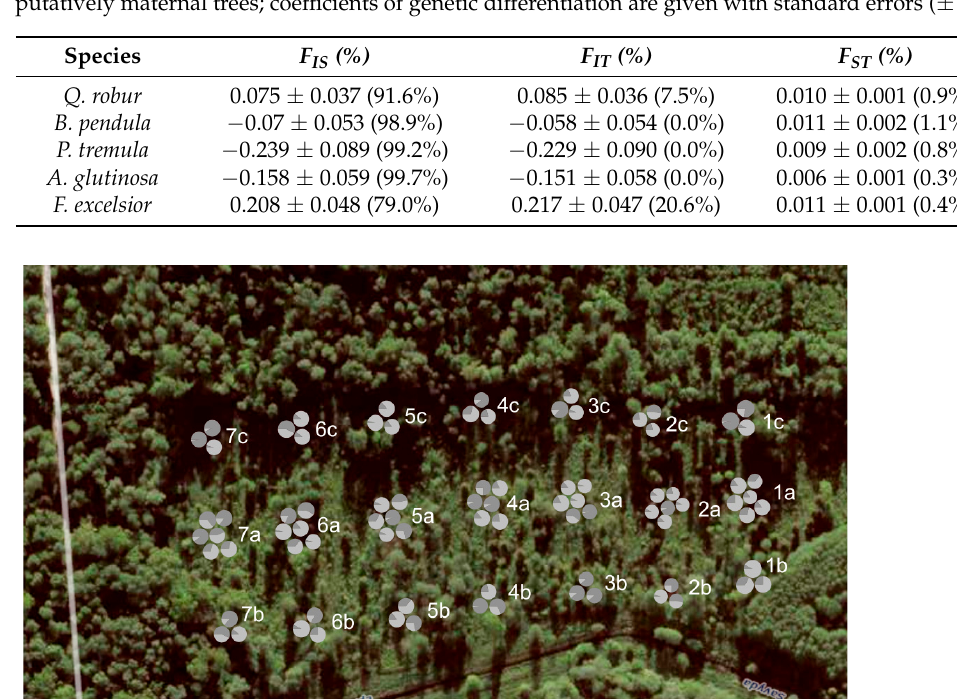
Table 4. Coefficients of genetic differentiation and percentage of AMOVA (%), given in brack- ets, calculated for eight microsatellite loci in five broadleaved tree species: common oak ( Quercus robur L.), silver birch ( Betula pendula Roth.), European aspen ( Populus tremula L.), black alder ( Alnus glutinosa (L.) Gaertn.), and European ash ( Fraxinus excelsior L.). F IS , genetic differentiation within sampled trees of the respective species; F IT , genetic differentiation among sampled trees of the respective species; F ST , genetic differentiation (genetic distance) between regenerating juveniles and putatively maternal trees; coefficients of genetic differentiation are given with standard errors ( ± SE).